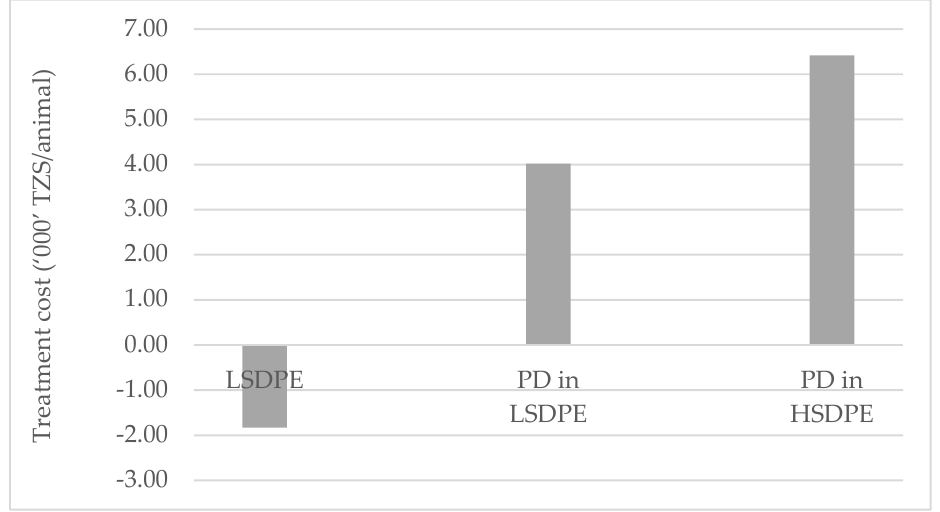
Figure 4. Mean differences in treatment cost per animal (‘000’ TZS/animal) in positive deviants (PD) and typical farms under low-stress (LSDPE) and high-stress (HSDPE) environments (2297.53 TZS = 1 US Dollar).